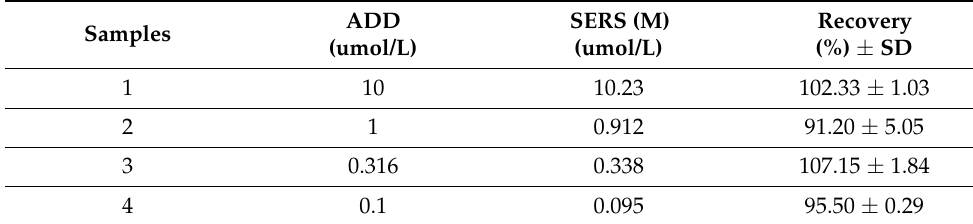
Table 1. Detection recovery of tyramine in Beer by Co 400 -ZnO/Au-based SERS.